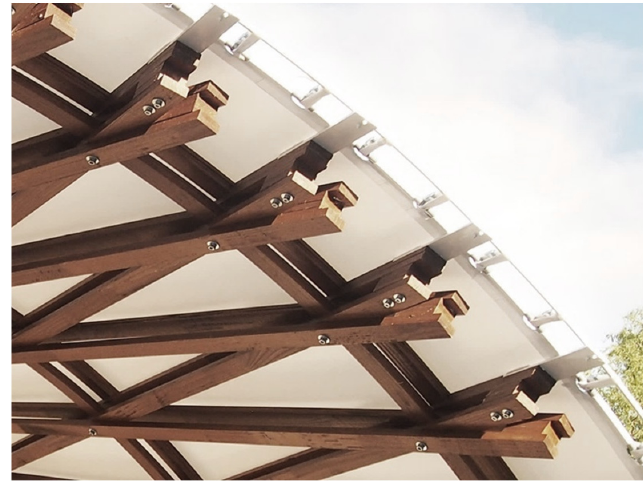
Figure 27. Detail of the end of the laths at the short edge of the structure.